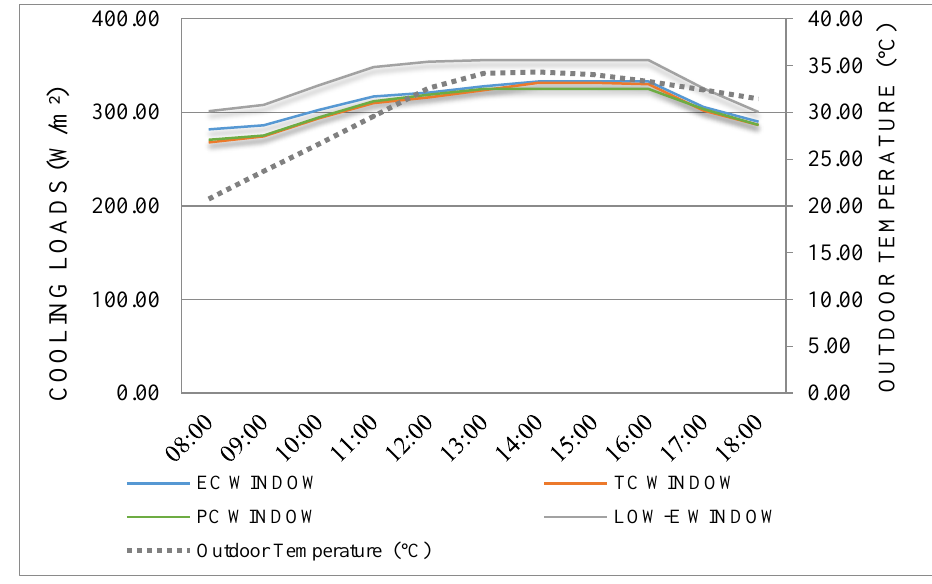
Figure 7 Cooling loads of windows for August 14 in